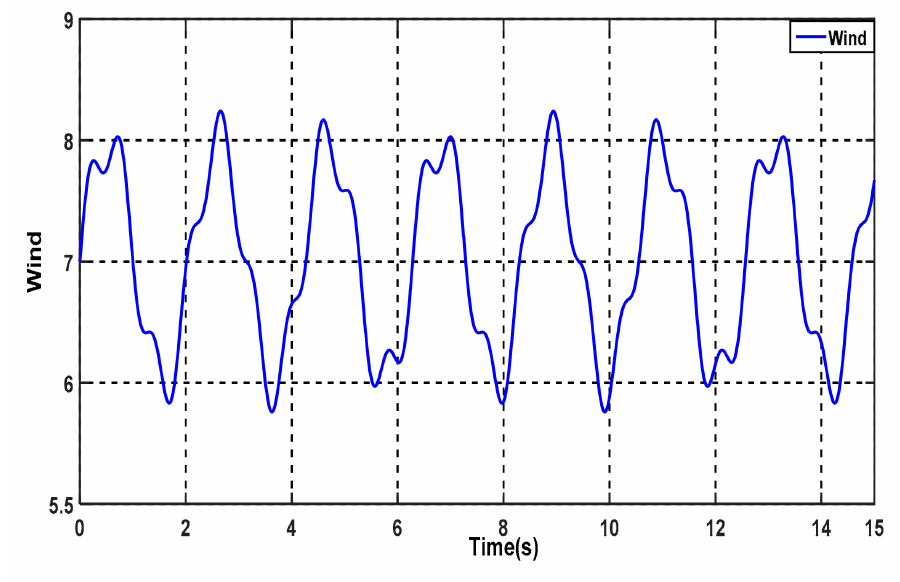
Figure 6. Wind speed